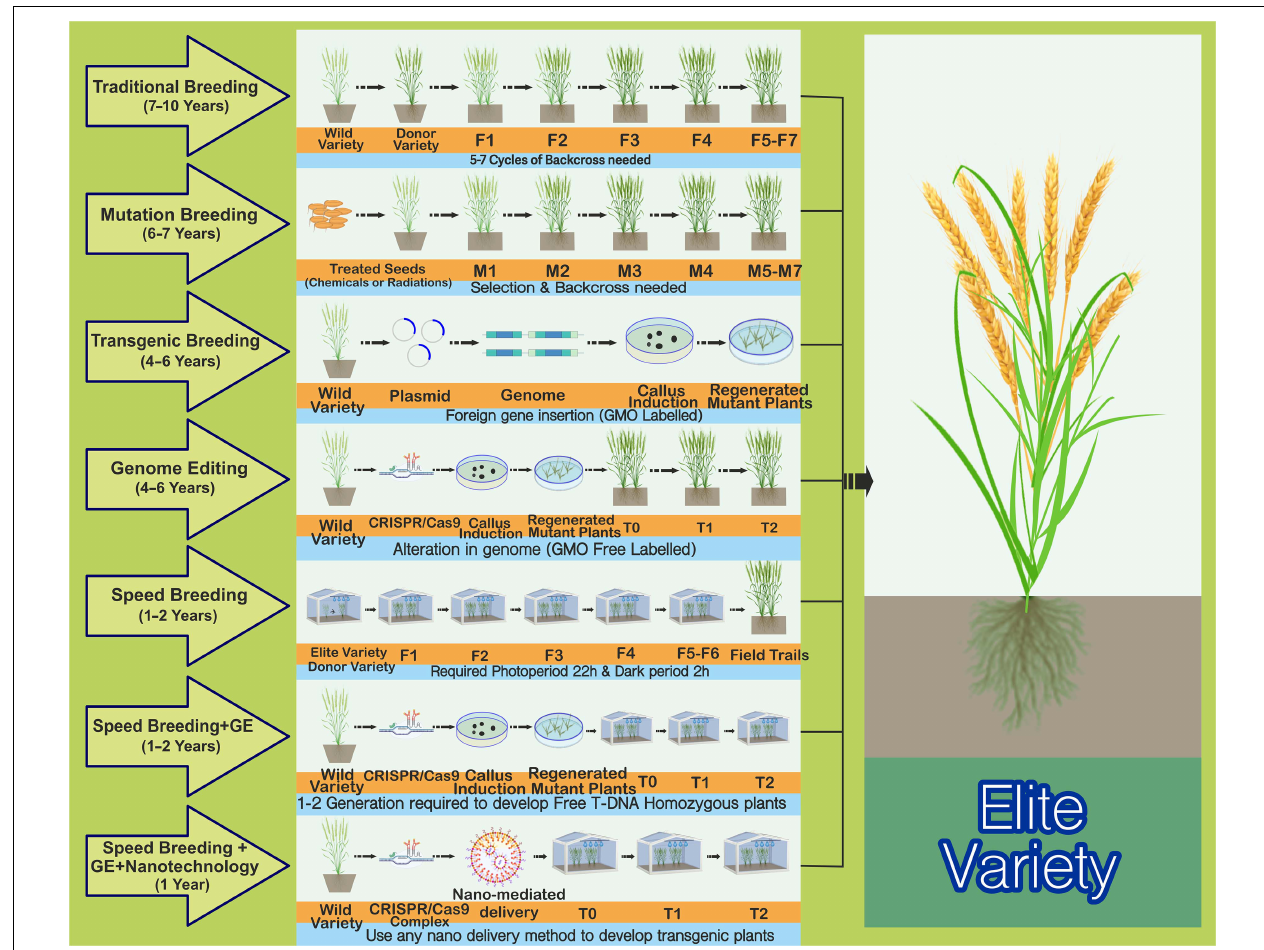
FIGURE 1 | Comparison of the most commonly employed plant breeding mutagenic and time-saving strategies for crop improvement. Traditional plant breeding is used to enhance plant characteristics. The complex successive backcrossing and rigorous selection process of the elite recipient’s parent line with a donor line leads to the development of an outstanding progeny with desired traits. This is a time-consuming, laborious, and less-effective technique. Mutation breeding , also known as “variation breeding,” refers to seeds being treated with chemicals or radiation to produce mutants with suitable characteristics to develop elite cultivars. It would require 6–7 years to produce desirable outcomes and is also a time-consuming process. Random mutations in the genome are one of the critical drawbacks and disadvantages of this strategy. Transgenic breeding has been successfully utilized to improve various crops with different traits by importing a gene of interest from one plant genome to another. These are regarded as genetically modified organisms (GMOs) owing to the insertion of foreign DNA/elements into the genome, and one of the biggest problems with GMOs is their comparative lack of acceptance among the public and a large group of plant scientists worldwide. Genome editing (GE) methods, such as the CRISPR/Cas9 method for trait improvement, provide a cost-effective, stable, time-saving, and less laborious solution than other existing techniques. Moreover, these methods can also be used to evade the GMO law, labeling the products as “non-GMO” because of the absence of any foreign DNA. Speed breeding that extends the photoperiod (22 h with 2 h of darkness in a 24-h diurnal cycle) improves the flowering time compared with that under normal conditions, potentially achieving four to six generations per year rather than the single generation achieved under normal conditions. Regarding photoperiod, continuous light is another option, but the dark period slightly improves the plant health. The optimal temperature regime (maximum and minimum temperatures) should be applied for each crop. This presents the best strategy for developing elite organic varieties within 1–2 years. The GE technology could also be improved by using speed breeding to establish a transgene-free plant within 1–2 years rather than waiting for an entire season under average growth. Another strategy involving nanotechnology and a combination of speed breeding and GE is proving reliable for speedy crop improvement. Here, plants can be grown under speed breeding conditions, and NPs coated with DNA, RNA, or RNP can deliver CRISPR reagents into meristematic cells. Transgene-free edited plants are obtainable from the edited tissues, either sexually or